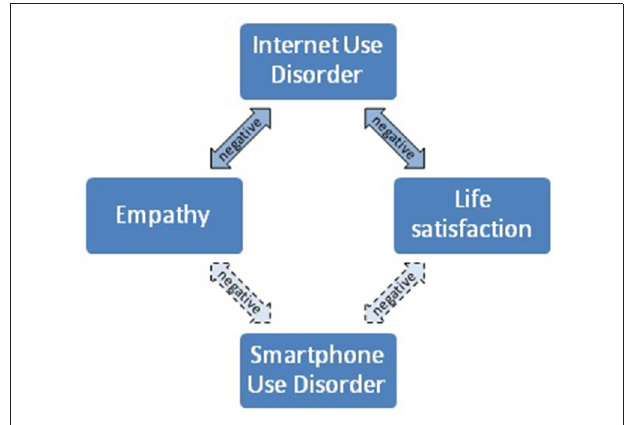
FIGURE 1 | Findings from the literature (solid arrows) and presumed (dashed arrows) associations (to be investigated in the present study) between IUD, empathy, life satisfaction, and